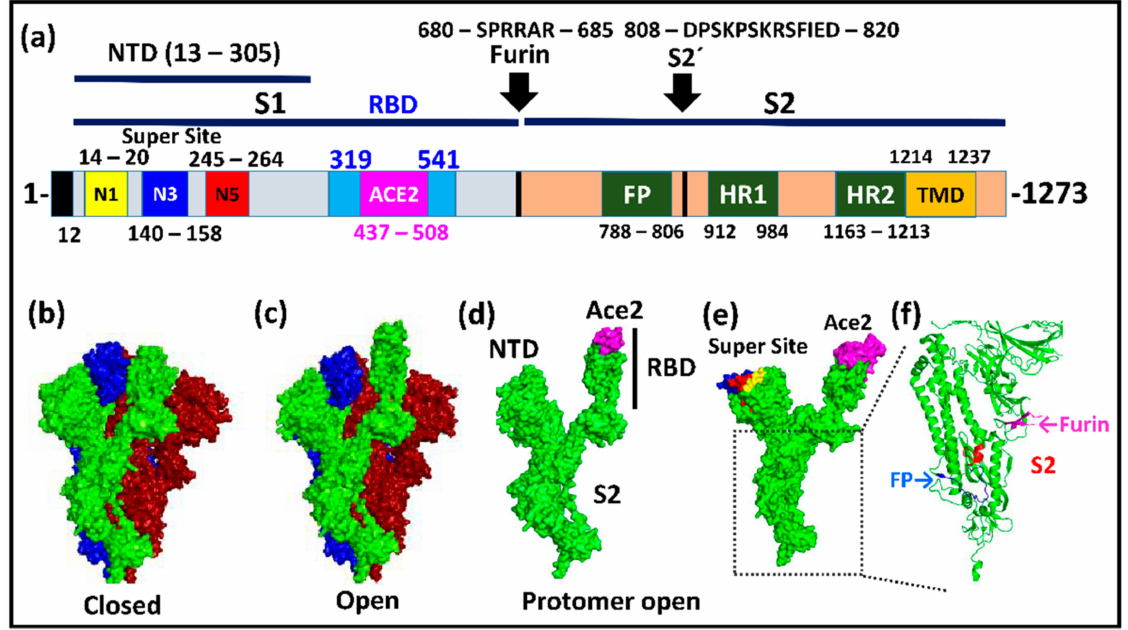
Figure 1. Domain Organization of the SARS-CoV-2 spike protein and structural features. ( a ) Domain organization of spike. Signal peptide: 1–12aa; S1-domain: 13–685aa; S2-domain: 686–1273aa; N-terminal domain (NTD): 13–305aa; Supersite